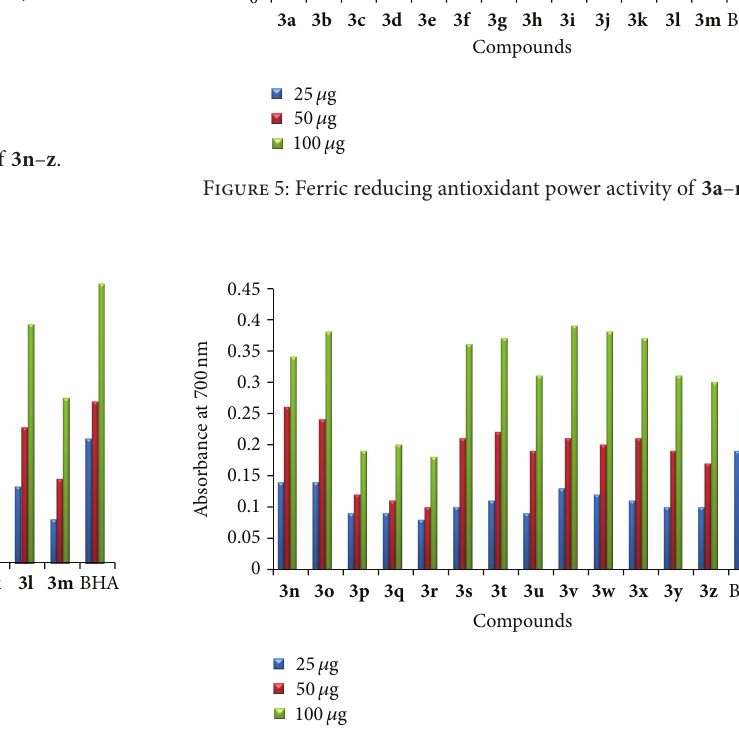
Figure 6: Ferric reducing antioxidant power activity of 3n – z